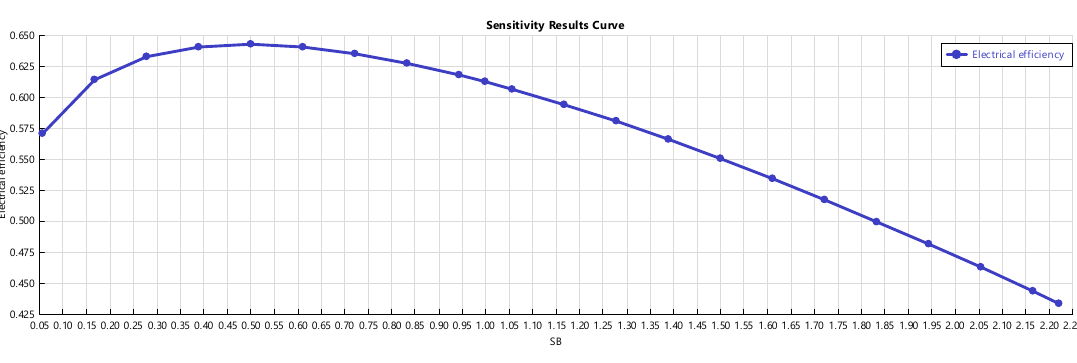
Figure 4. E ff ect of the S / B ratio on electrical e ffi Figure 4. Effect of the S/B ratio on electrical efficiency. Figure 4. Effect of the S/B ratio on electrical efficiency.